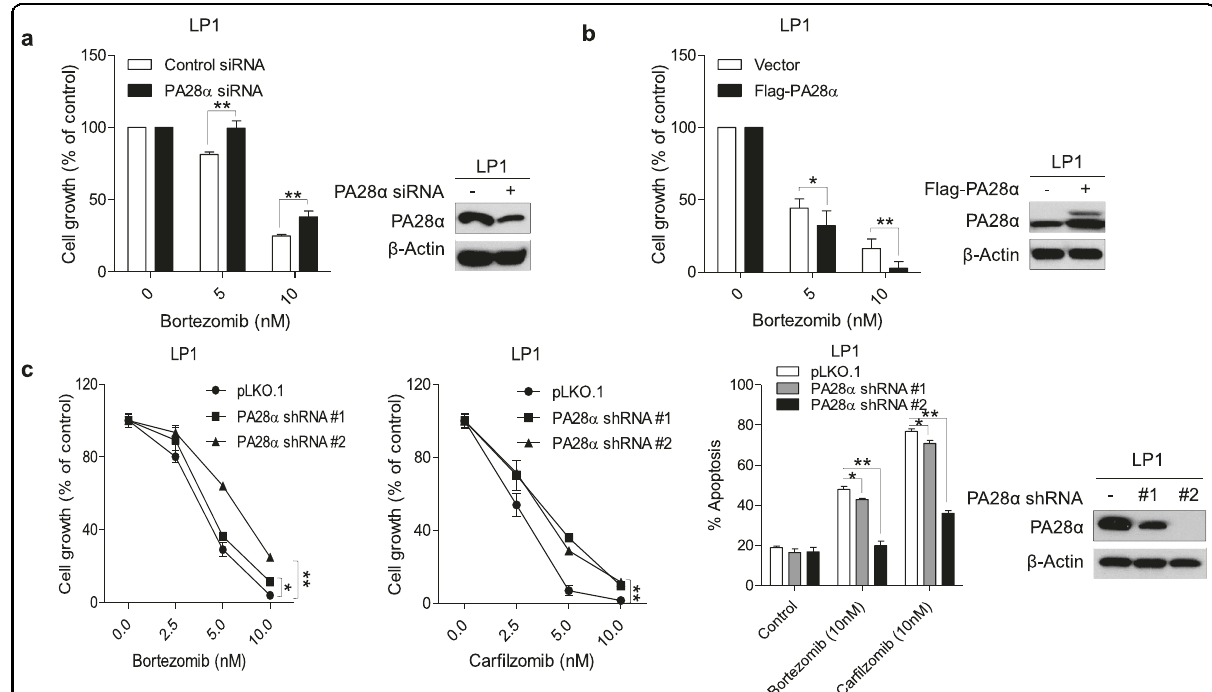
Fig. 2 PA28 α regulates multiple myeloma sensitivity to PIs. a LP1 cells were transfected with PA28 α siRNA for 72 h, cells were then treated with bortezomib for 24 h and MTT assay was performed to analyze cell growth. b LP1 cells were transfected with Flag-PA28 α for 48 h, cells were then treated with bortezomib for 24 h, and MTT assay was performed to analyze cell growth. c MTT assay and Annexin V/Propidium Iodide (PI) fl ow cytometry assay of LP1 PA28 α knockdown stable cells under exposure to different concentrations of bortezomib or car fi lzomib for 48 h. Western blot was performed to show PA28 α expression. * P < 0.05, ** P < 0.01, Student ’ s t